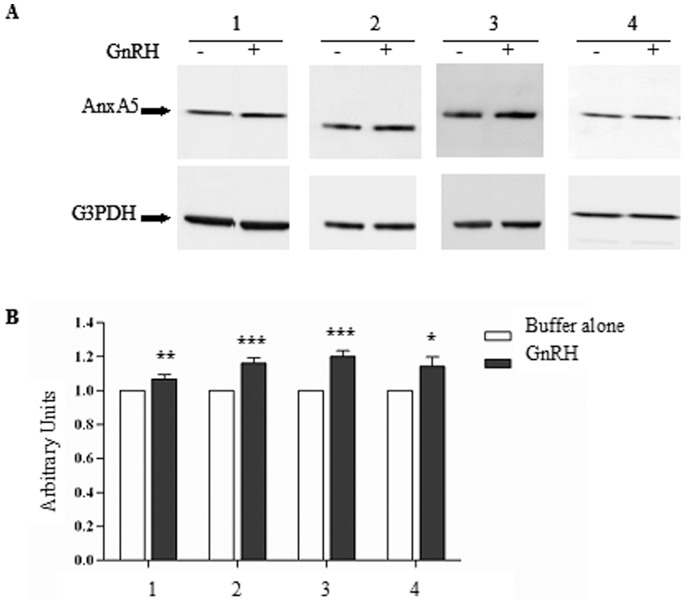
AnxA5 expression when cells are treated for 60 min with GnRH.
A. Representative immunoblots showing AnxA5 and G3PDH expression in 16HBE14o− (1), CFBE41o− (2), CFBE41o−/corr (3) and CFBE41o−/F508del (4) cells after 60 min of treatment by GnRH (10−9 M). An increased expression is observed in all cell types. B. Densitometric analysis of AnxA5 expression. Data are normalized by G3PDH. AnxA5 protein expression is presented as mean ± S.E.M (7 independent experiments with n ≥2 for each experiment). For each cell line, the statistical analysis was performed by comparing the normalized amount of AnxA5 between cells incubated with buffer alone (white bars adjusted to 1) and cells incubated with GnRH (black bars).